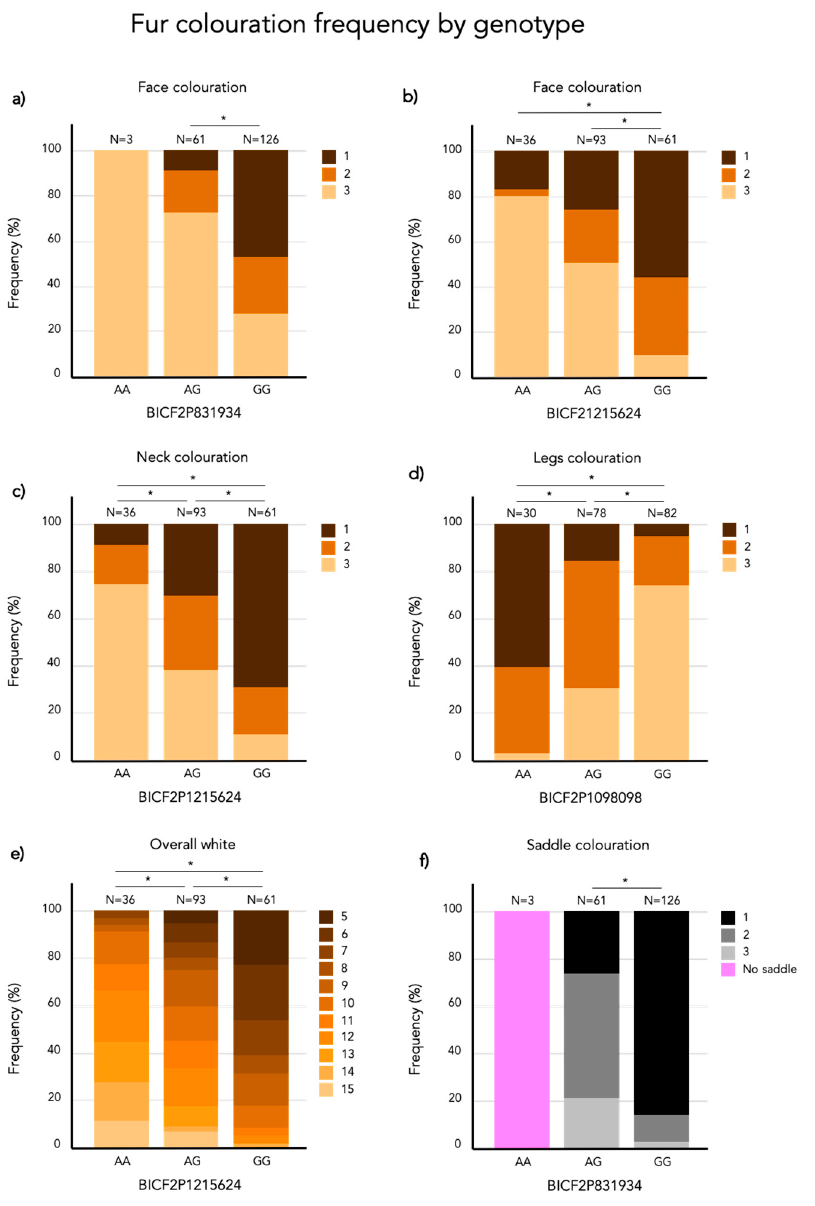
Figure 9. Stacked bar plot of the frequency (%) of each phenotype score per genotype of the most associated SNP marker for ( a ) face coloration (chr 5), ( b ) face coloration (chr 20), ( c ) neck coloration, ( d ) leg coloration, ( e ) overall white and ( f ) saddle coloration. Significant differences ( p < 0.05) are marked with *. The numbers above each bar represents the total number of individuals carrying that genotype.